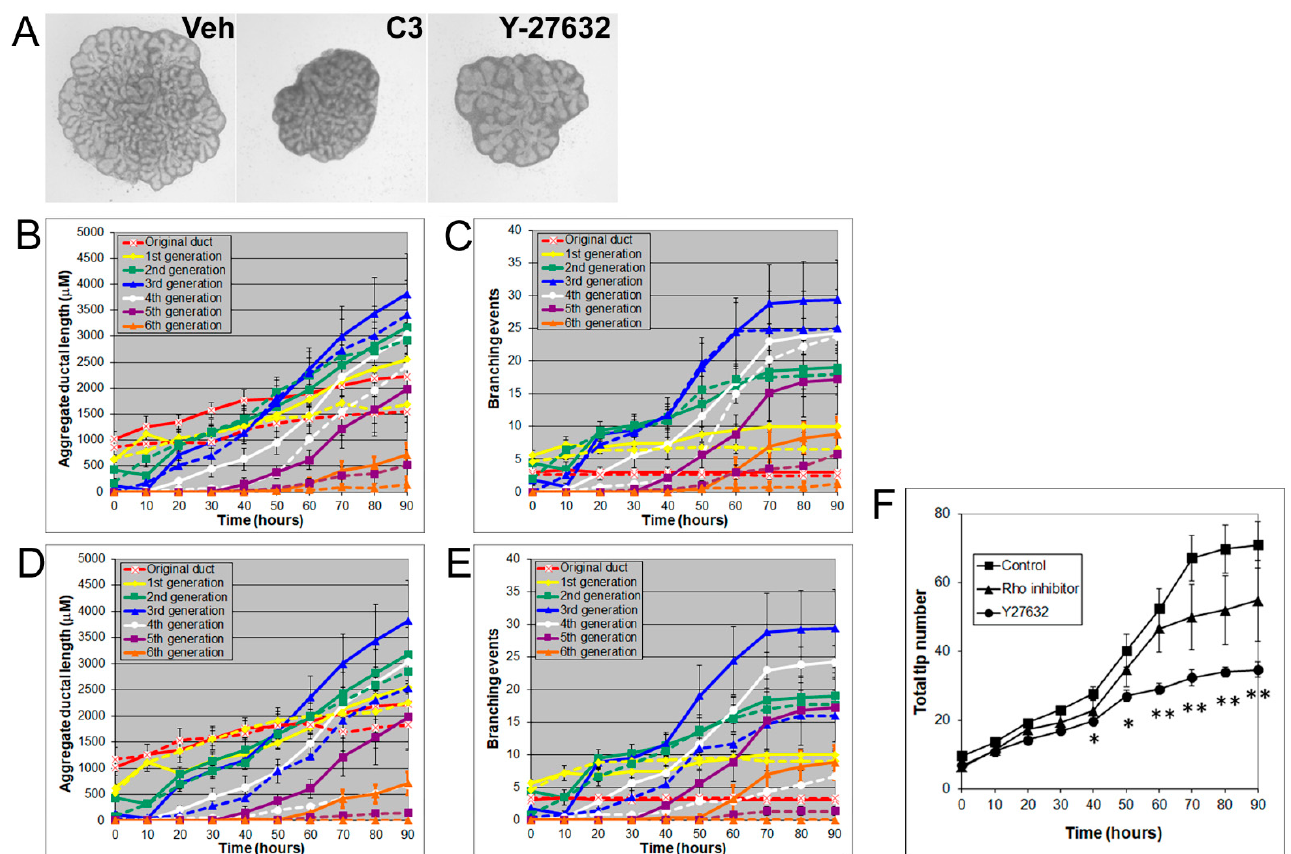
Figure 5. ( A ) Branch generations of contralateral rat pnd 0 VPs cultured for 90 h with vehicle control (left), 2 μ g/mL C3 transferase (middle), or 20 μ M Y-27632 (right). Successive images were taken every 30 min for 90 h to track branching events. Representative end-point images at 90 h are shown. Note that there were fewer branch formations in the second to fifth generation with both C3 transferase and Y-27632 treatments. ( B ) Kinetics of prostatic bud and duct elongation over successive branch generations in pnd 0 VPs cultured for 90 h in the absence (solid lines) or presence of 2 μ g/mL C3 transferase (dashed lines). The data show the aggregate length ( μ m) of all ductal segments in each successive branch generation over time. ( C ) Total number of branch point events in each ductal generation as a function of time. Solid lines represent data from untreated VPs, and dashed lines represent data from 2 μ g/mL C3-transferase-treated VPs. Error bars denote SEM from 4 sets of experiments. Differences between the two groups were statistically significant ( p < 0.05) from 20 h onward, except for the original ducts. ( D ) Kinetics of prostatic bud and duct elongation over successive branch generations in pnd 0 VPs cultured for 90 h in the absence (solid lines) or presence of 20 μ M Y-27632 (dashed lines). Data show the aggregate length ( μ M) of all ductal segments in each successive branch generation over time. ( E ) Total number of branch point events in each ductal generation as a function of time. Solid lines represent data from untreated VPs, and dashed lines represent data from 20 μ M Y-27632-treated VPs. Error bars denote SEM from 4 sets of experiments. Differences between the two groups were statistically significant ( p < 0.05) from 20 h onward except for the original ducts. ( F ) Total tip number in 3D analysis as a function of time in rat pnd 0 untreated VPs (squares), 2 μ g/mL C3 transferase-treated VPs (triangles), and 20 μ M Y-27632-treated VPs (circles) cultured for 90 h. Each data point represents the mean of 4 sets of experiments, and bars denote SEM. * denotes significant differences between control and treatments, * p < 0.05, ** p < 0.01.